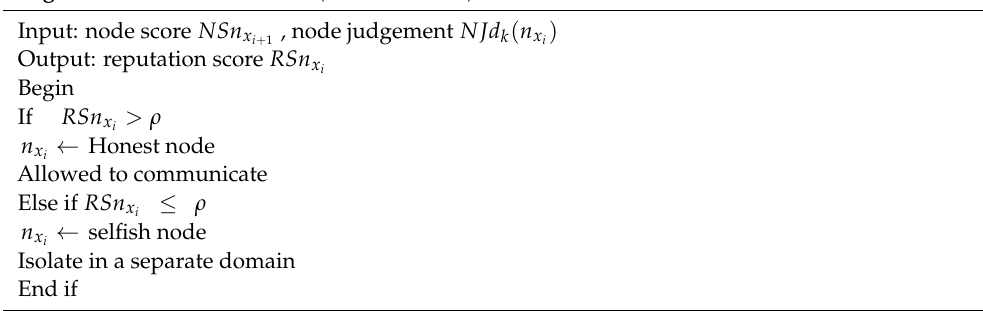
Algorithm 5 Node’s behavior